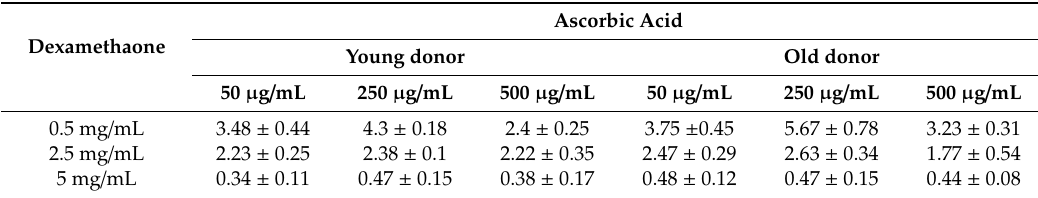
Figure 5. Real-time changes of cell index when tenocytes were exposed to 0.5 mg / mL of dexamethasone and di ff erent concentrations of ascorbic acid. ( a ) Cell index when tenocytes were exposed to 50, 250, and 500 µ g / mL ascorbic acid in the 20-year-old patient. ( b ) Cell index when tenocytes were exposed to 50, 250, and 500 µ g / mL ascorbic acid in the 41-year-old patient. * p < 0.05. Table 2. Cell index at 190 h when tenocytes from young and old donors were exposed to dexamethasone and ascorbic acids